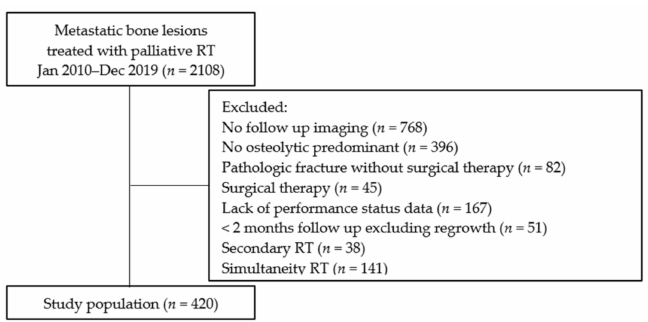
Figure 1. Flow chart. RT, external beam